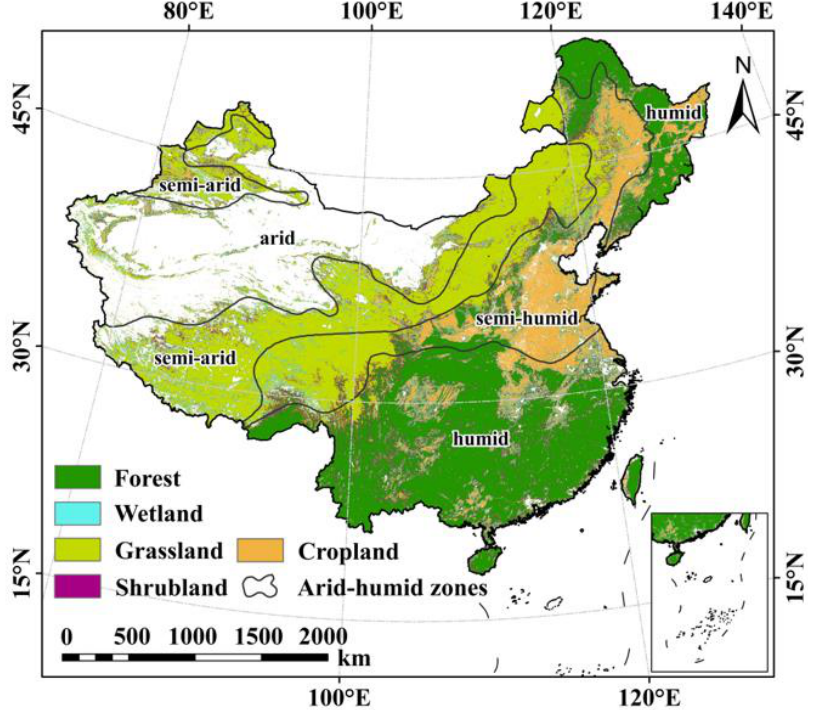
Figure 1. Distribution of different arid-humid zones and vegetation types across China.